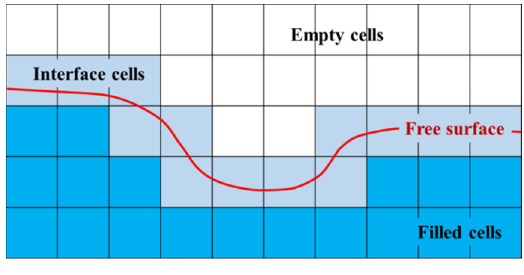
Figure 1. Cell types of SPFS-LB method.